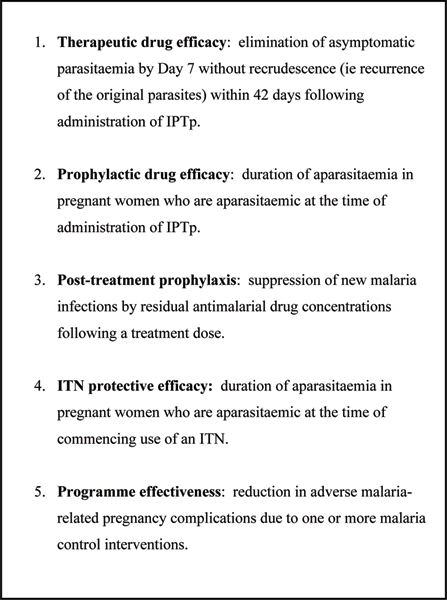
Definition of parameters for assessment of malaria control in pregnancy.